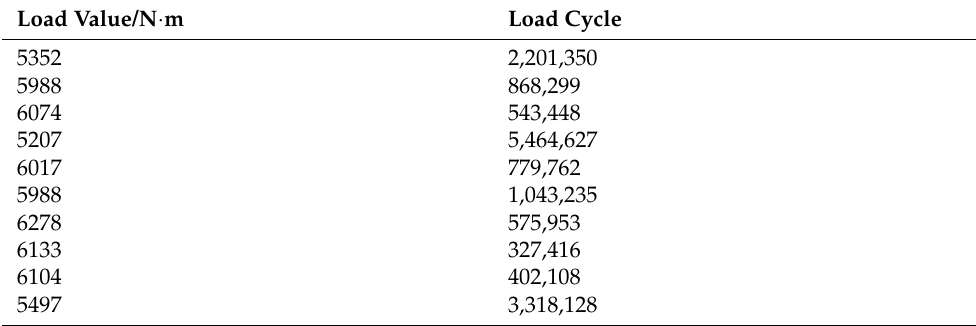
Table 6. The fatigue test results of the